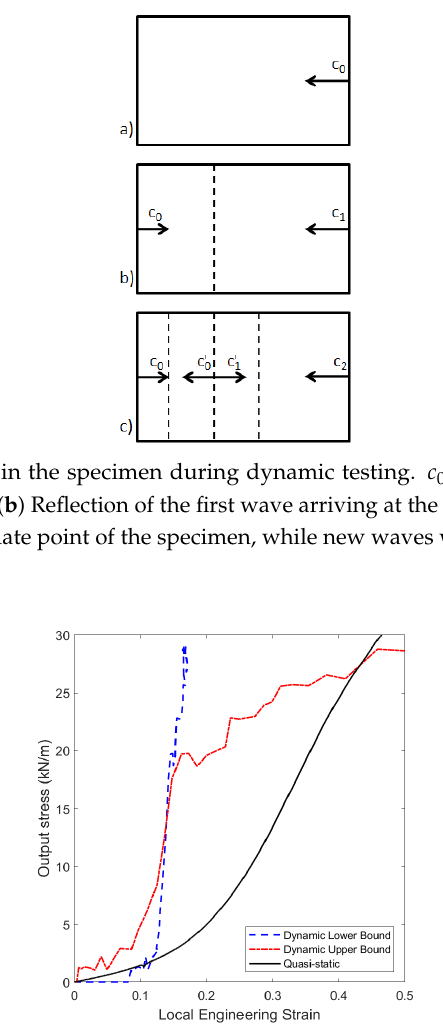
Figure 12. Output stress vs. local engineering strain at different locations of the specimen. Blue dashed line stands for the local strain at the output interface (dynamic lower bound, X = 0 mm in Figure 10) and red dashed line stands for the local strain at the input interface (dynamic upper bound, X = 34 mm in Figure